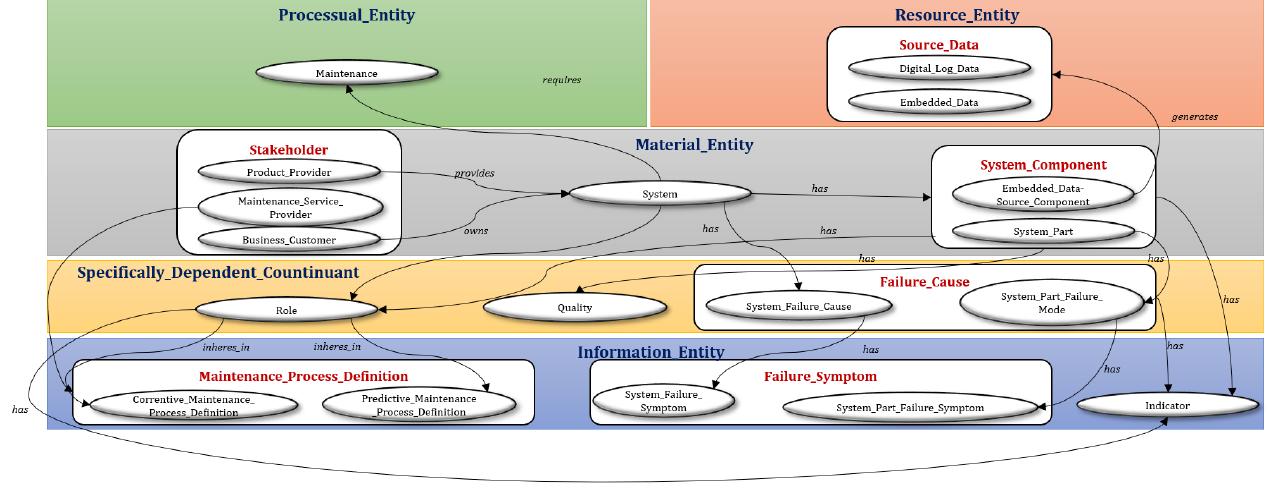
Figure 2. Logical diagram of the maintenance semantic model.